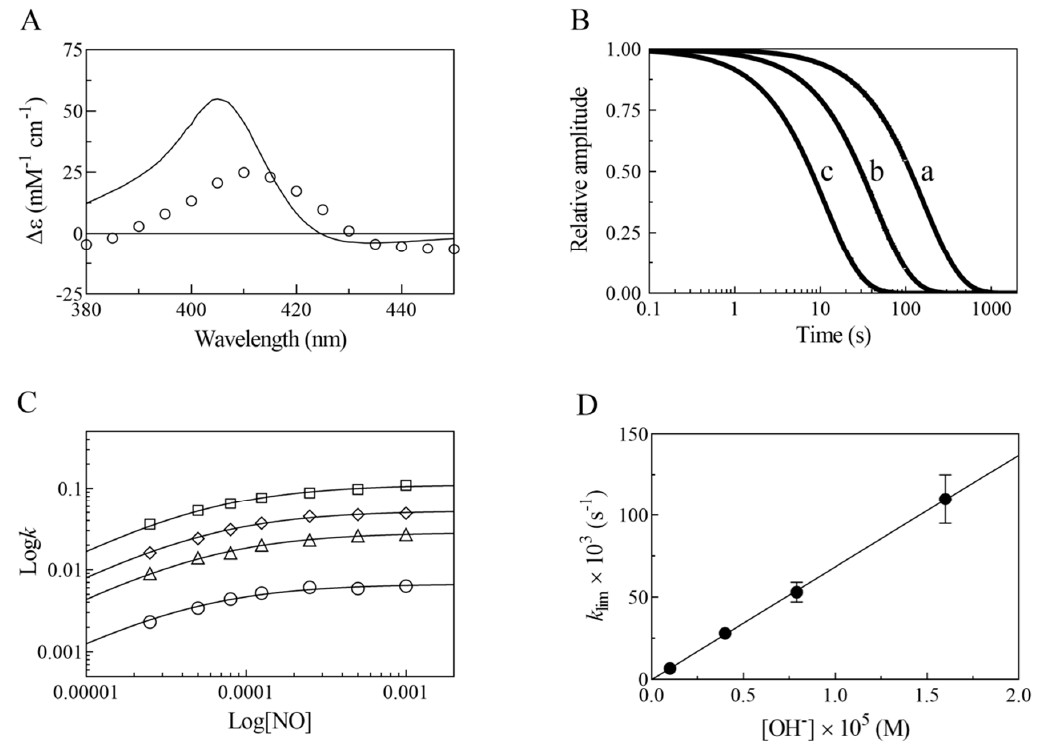
Figure 2. Reductive nitrosylation of Hs -Nb(III) at 20.0 °C. ( A ) Difference optical absorption spectrum of Hs